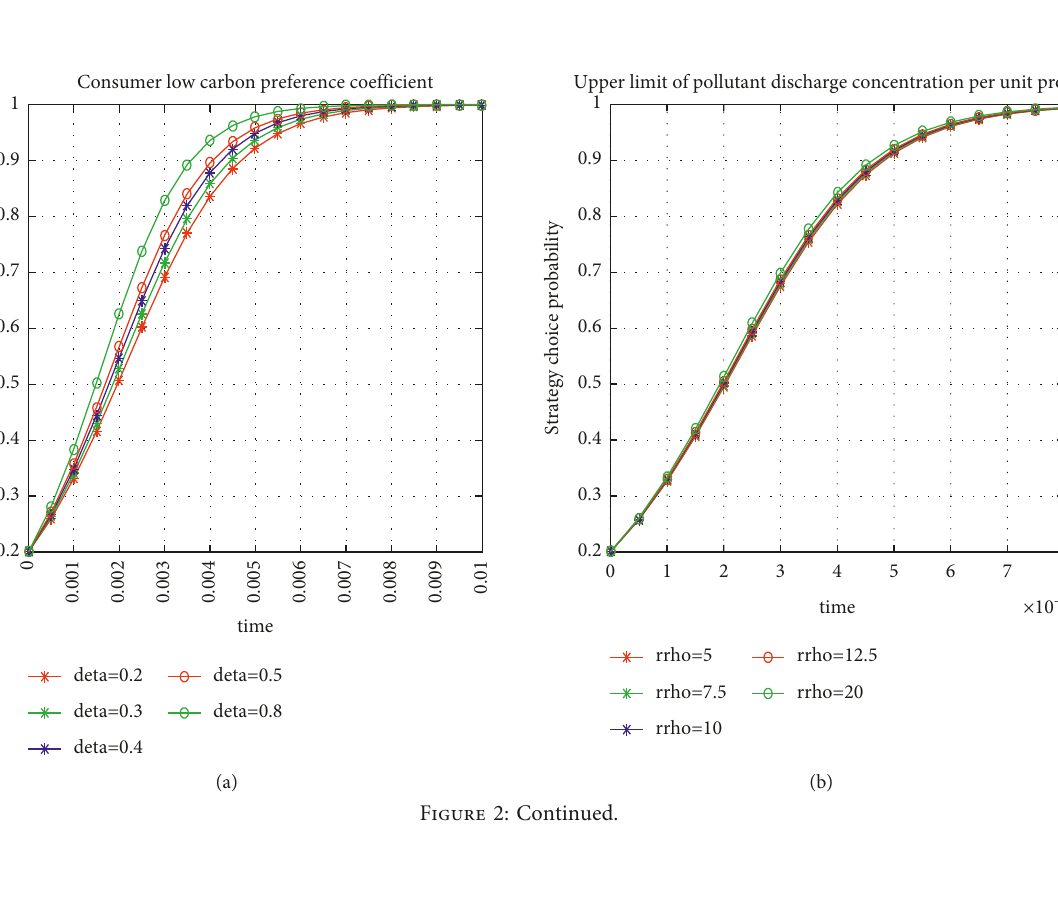
Figure 1: Dynamic phase diagram.